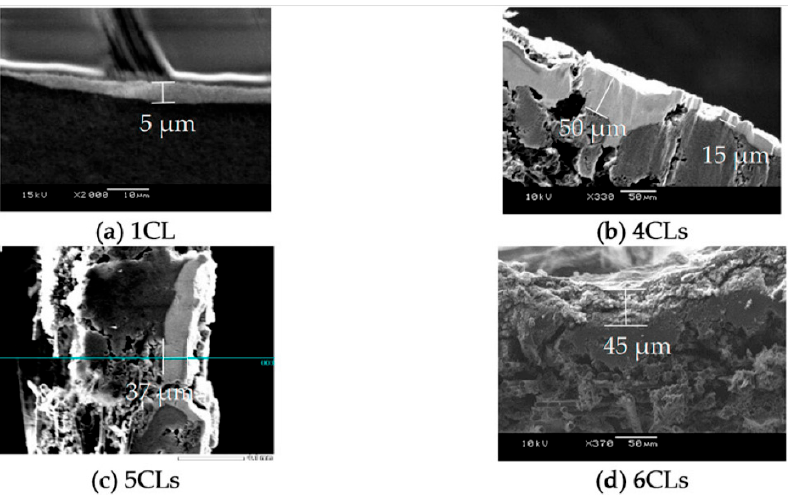
Figure 3. Comparison of SEM image of the cross-sectional area of each CL; ( a ) 1CL, ( b ) 4CLs, ( c ) 5CLs and ( d ) 6CLs.